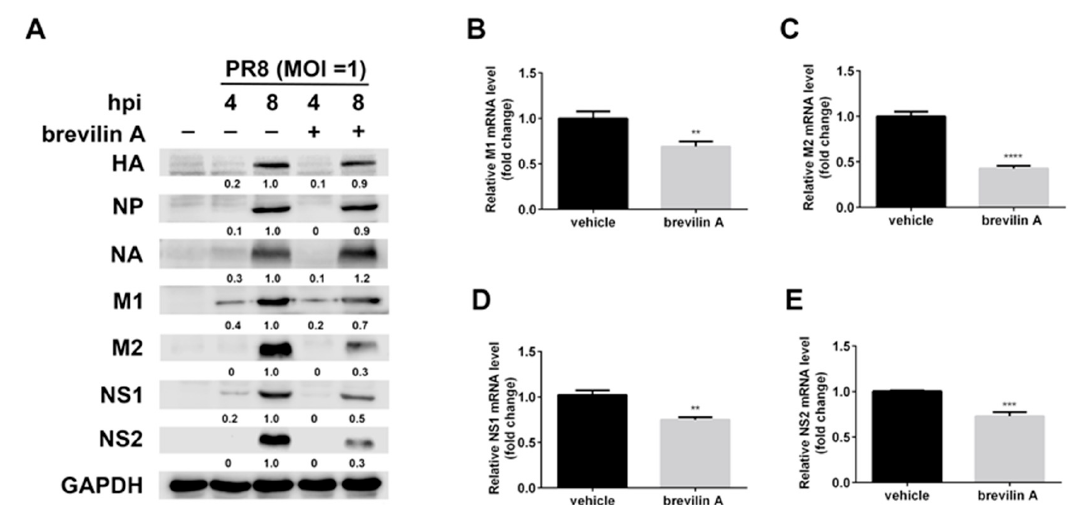
Figure 5. The inhibitory e ff ects of brevilin A on the mRNA and protein expression of viral NS and M. ( A ) MDCK cells were infected with PR8 at a MOI of 1, and then treated with brevilin A or vehicle. At the indicated time points, cell lysates were analyzed by Western blot assay for the indicated antigens; ( B – E ) MDCK cells were infected with PR8 at a MOI of 1, and then treated with brevilin A (8 µ M) at 1 hpi, total RNA was extracted from the infected cells at 6 hpi, and mRNA was quantified with RT-qPCR. *, p < 0.05; **, p < 0.01; ***, and p < 0.001 are considered statistically significant, compared with